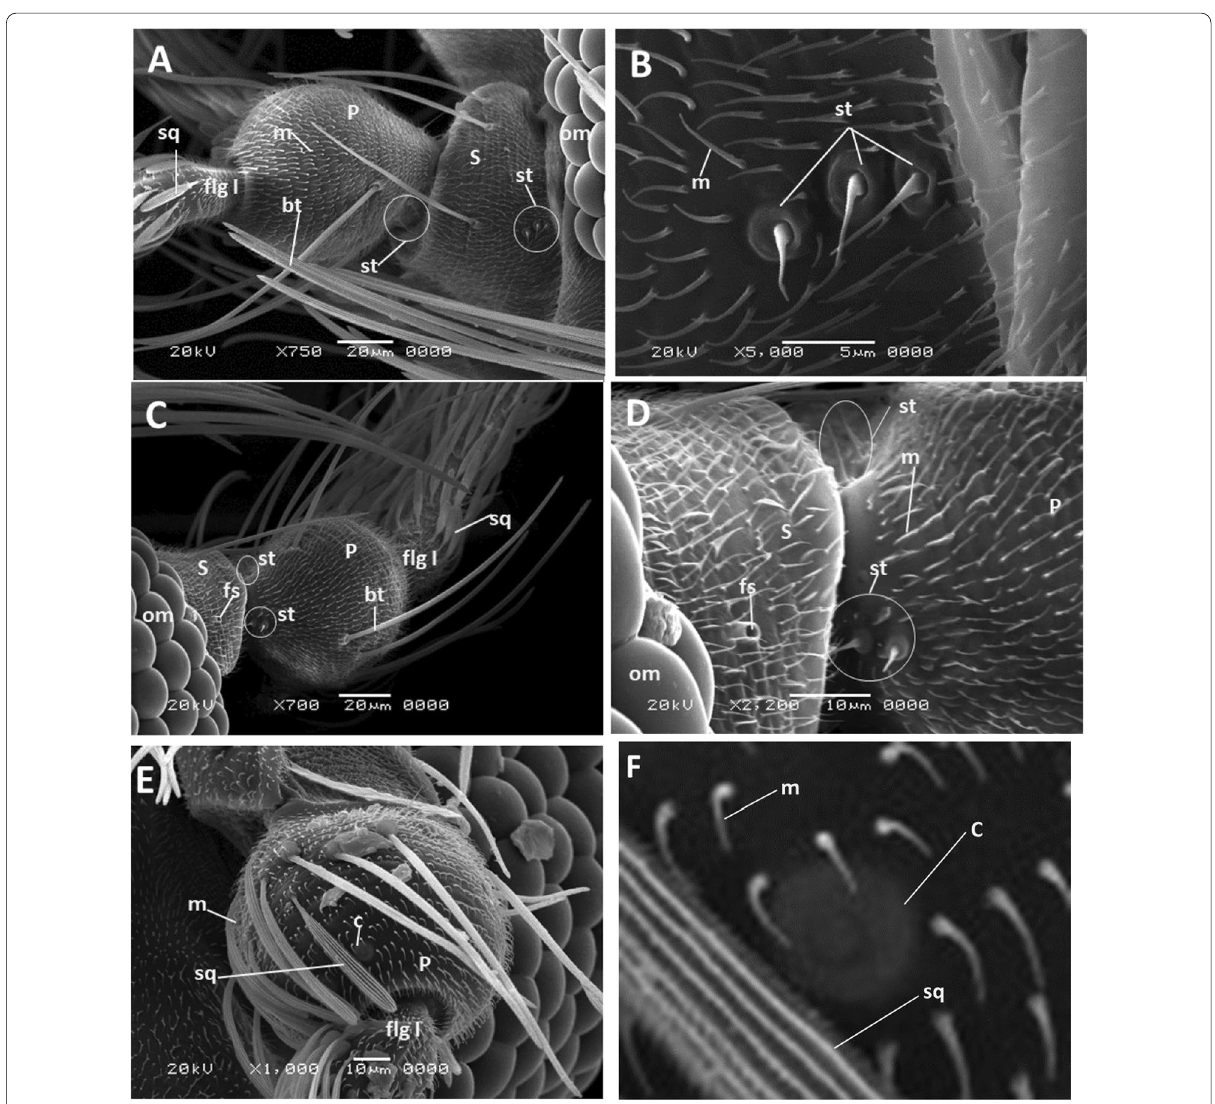
Fig. 2 SEM micrographs of the antennae of female and male Phlebotomus papatasi . A Lateral view of the female first two segments and first flagellomere showing, scape (S) and pedicel (P); with short-tipped trichoid (st); arranged in a set of three on the scape and a set of two on the pedicel; long blunt-tipped trichoid (bt) sensilla; next to some ommatidia (om); and squamiform (sq) sensillum on the first flagellomere (flg I); and microtrichiae (m) covering the surface of these antennal segments. B Three short sharp-tipped trichoid (st) sensilla observed in higher magnification on scape (encircled area) in female. C Male antenna showing, pedicel (P) with set of three short sharp-tipped trichoid (st); two short sharp-tipped trichoid (encircled area); a fallen sensillum insertion site (fs). D Higher magnification of short sharp-tipped trichoid (st) observed in a set of two and three on pedicel of male (encircled) area. E Campaniform (c) sensillum; surrounded by microtrichiae (m) on the pedicel of female. F Higher magnification of campaniform (c) sensillum; long blunt-tipped sensillum (bt); microtrichia (m) on the pedicel of